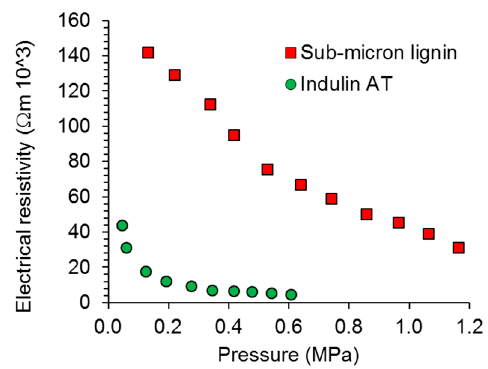
Figure 3. Pressure-dependent electrical resistivity of the two types of lignin-derived carbon powder.